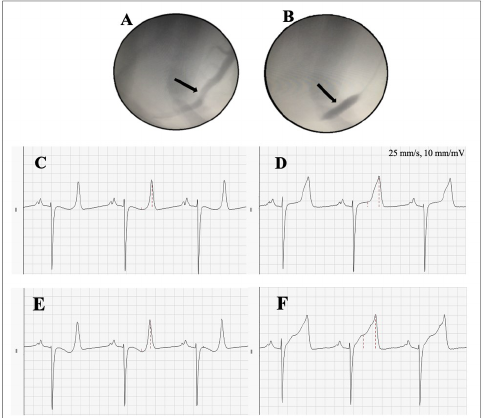
Figure 1. Occlusion of the left anterior descending (LAD) coronary artery and the corresponding electrocardiogram (ECG). A : Angiogram of the LAD (arrow), B : Showing the balloon catheter posi- tioned distally in the LAD (arrow), C : Lead II two minutes before occlusion, D : Lead II two minutes after the first occlusion, E : Lead II five minutes after reperfusion, F : Lead II two minutes after the second occlusion. In figure C-F the red dotted lines illustrate the points of measurements.